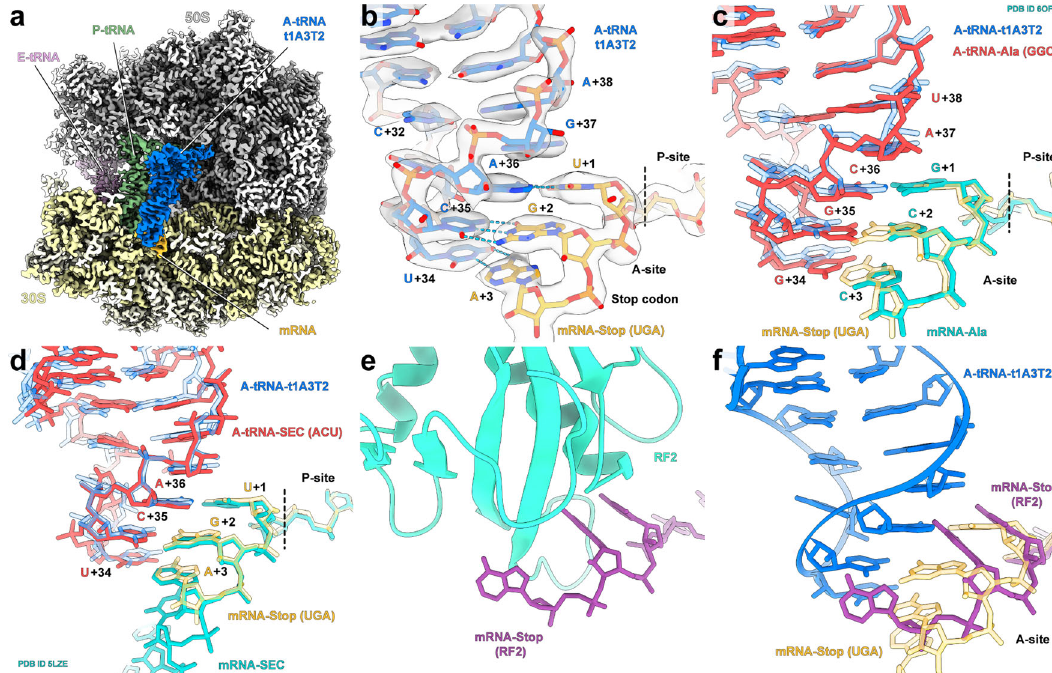
Fig. 4 t1A3T2 decoding mechanism is identical to elongator tRNAs. a Cryo-EM reconstruction of the t1A3T2 decoding UGA on the ribosome with segmented densities for t1A3T2 (blue), P tRNA (green), E tRNA (pink), 30S (yellow), and 50S (gray). b Close-up view of the anticodon stem loop of t1A3T2 (blue) showing three Watson – Crick pairing decoding UGA (pale orange). c Same view than b with an overlay between the cognate tRNA Ala GGC (red) bound to GCC codon (turquoise; PDB ID 6OF6) 25 . d Same view than b with an overlay between the Sec-tRNA Sec (red) bound to UGA codon (turquoise; PDB ID 5LZE) 40 . e Interaction of RF2 (cyan) with the decoding center (mRNA stop, violet; PDB ID 4V4T) 75 . f Same view than e without RF2 and overlay of t1A3T2 (blue) decoding UGA (pale